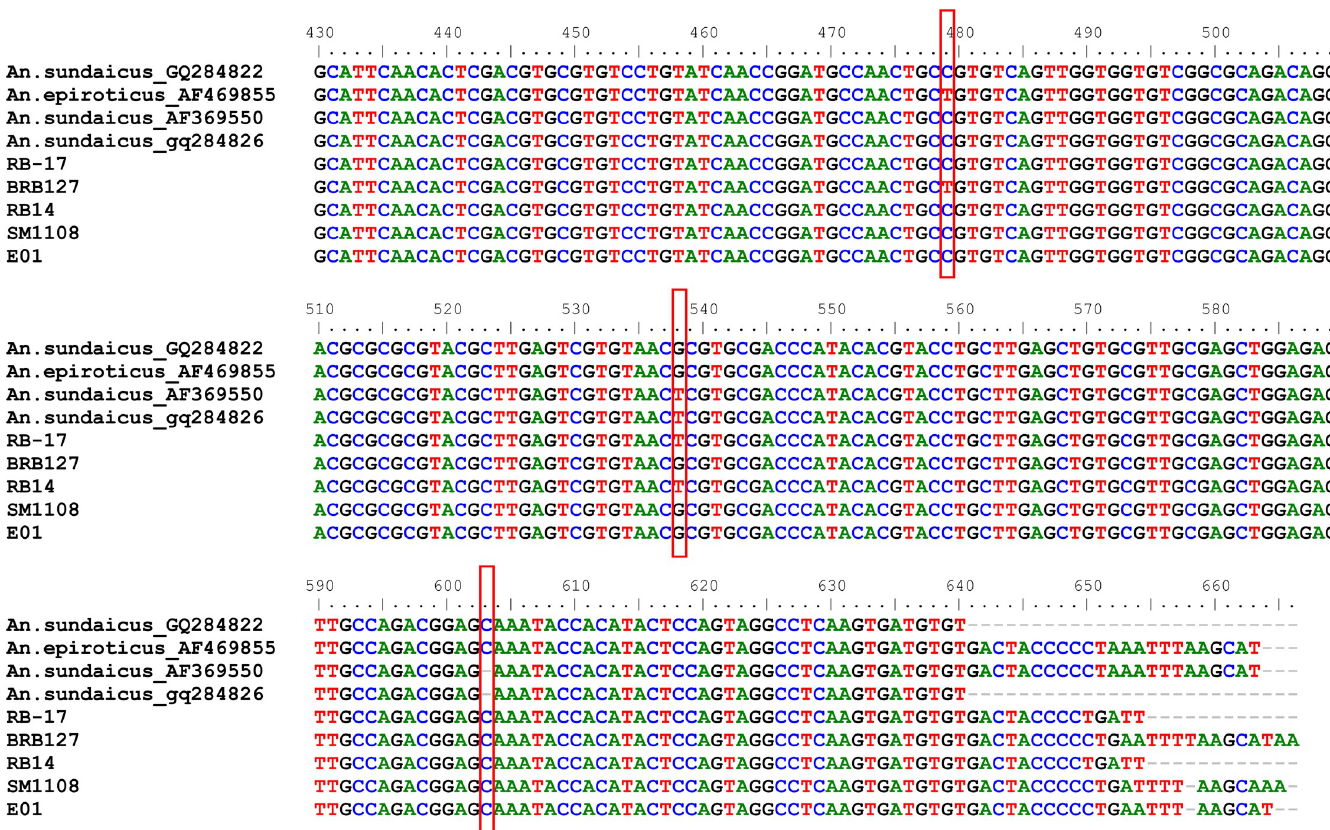
Fig 2. Alignment of rDNA ITS2 sequences from An . sundaicus s.l. (GenBank Acc. No. GQ284822, AF369550, GQ284826) and An . epiroticus (GenBank Acc. No. AF469855). Geographic origins of specimens indicated as RB-17 = Lampung, BRB-127 = North Sumatra, RB-14 = Lampung, SM1-108 = Sumba, East Nusa Tenggara, and E-01: Enggano,